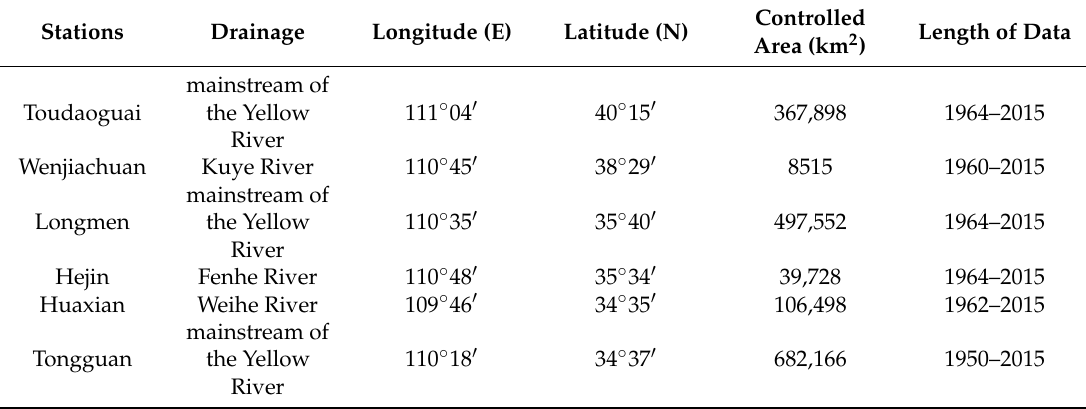
Table 1. Information of the hydrological stations.